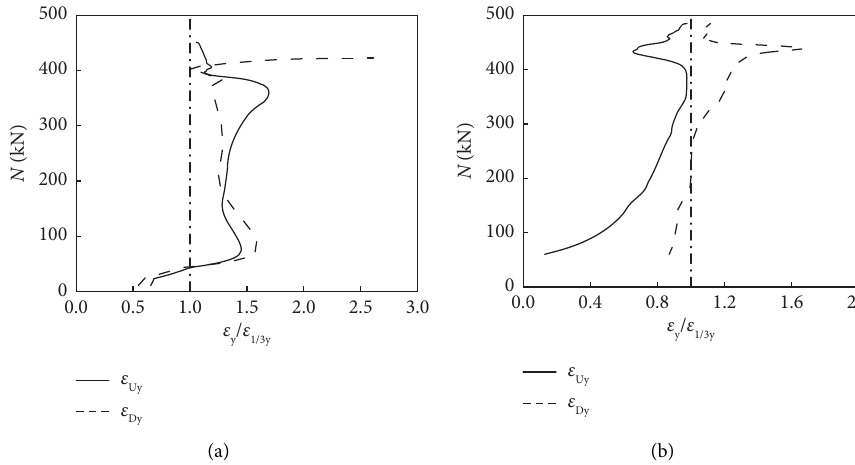
Figure 14: ε y / ε Uy and ε y / ε Dy with N curve: (a) 114-0 and (b) 114-30.